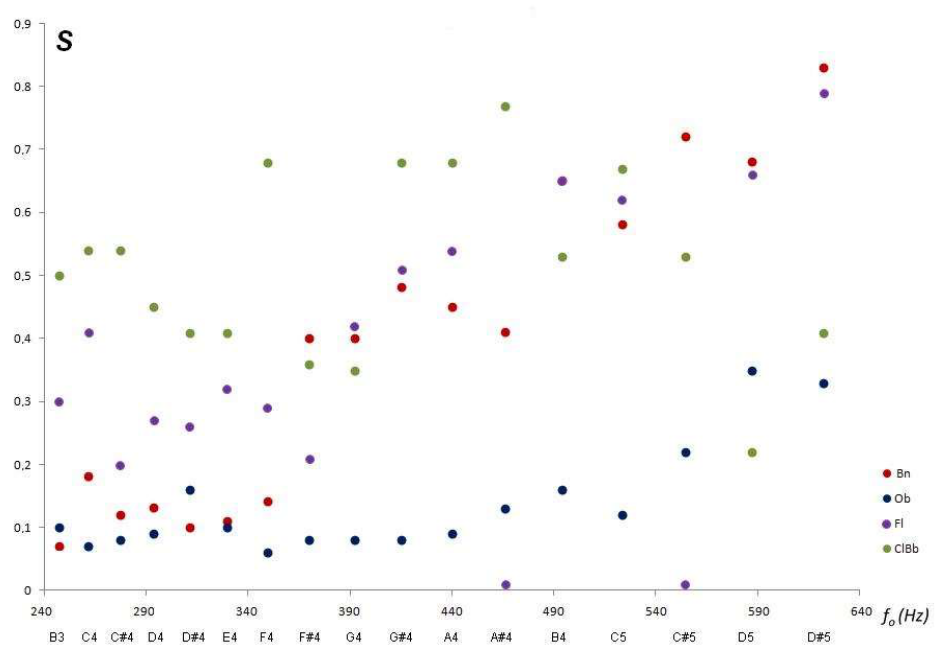
Figure 6. Variation of Sharpness ( S ) concerning common ranges.